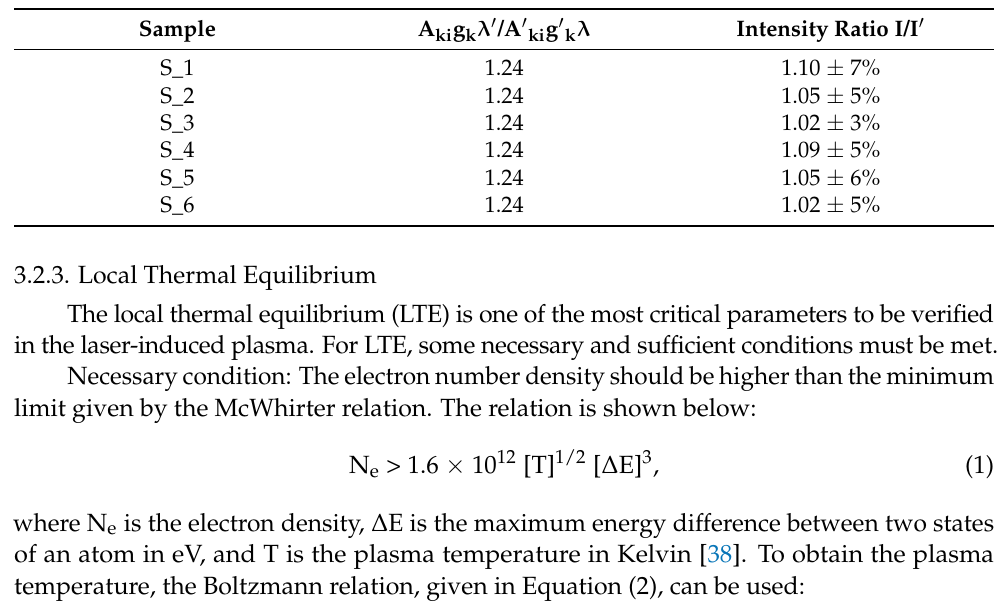
Table 3. Ratio of I/I (cid:48) and (A ki g k λ (cid:48) )/(A (cid:48) ki g (cid:48) k λ ) for persistent lines of Si at 250.60 and 251.44 nm for the different